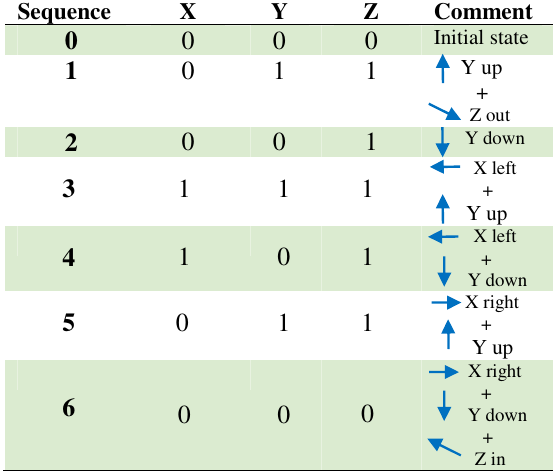
Enhanced on table 2, XYZ